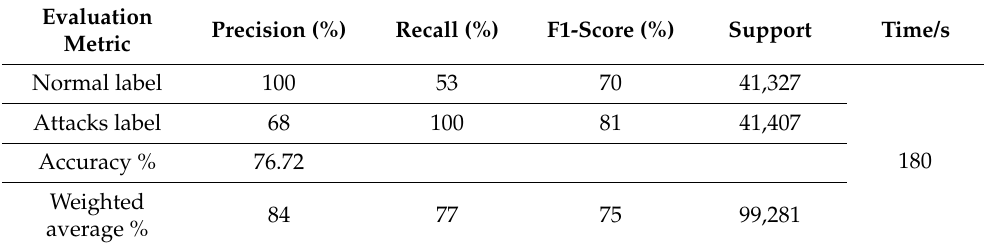
Table 6. Empirical results for the linear discriminant analysis